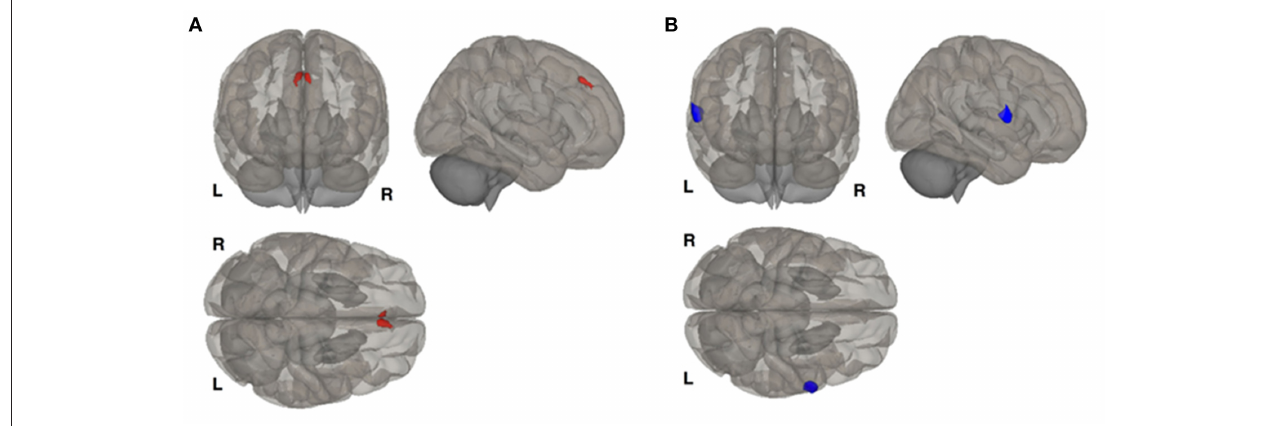
FIGURE 2 | Resting state functional connectivity differences between females with bipolar disorder and females with bipolar disorder and comorbid premenstrual dysphoric disorder. (A) Shows that left hippocampus seed is more connected with the right frontal cortex in females with the comorbid disorders. (B) Shows that right hippocampus is less functionally connected with left premotor cortex in females with the comorbid disorders. Results corrected for multiple comparisons using false discovery rate procedure. Reproduced with permission from Syan et al. (